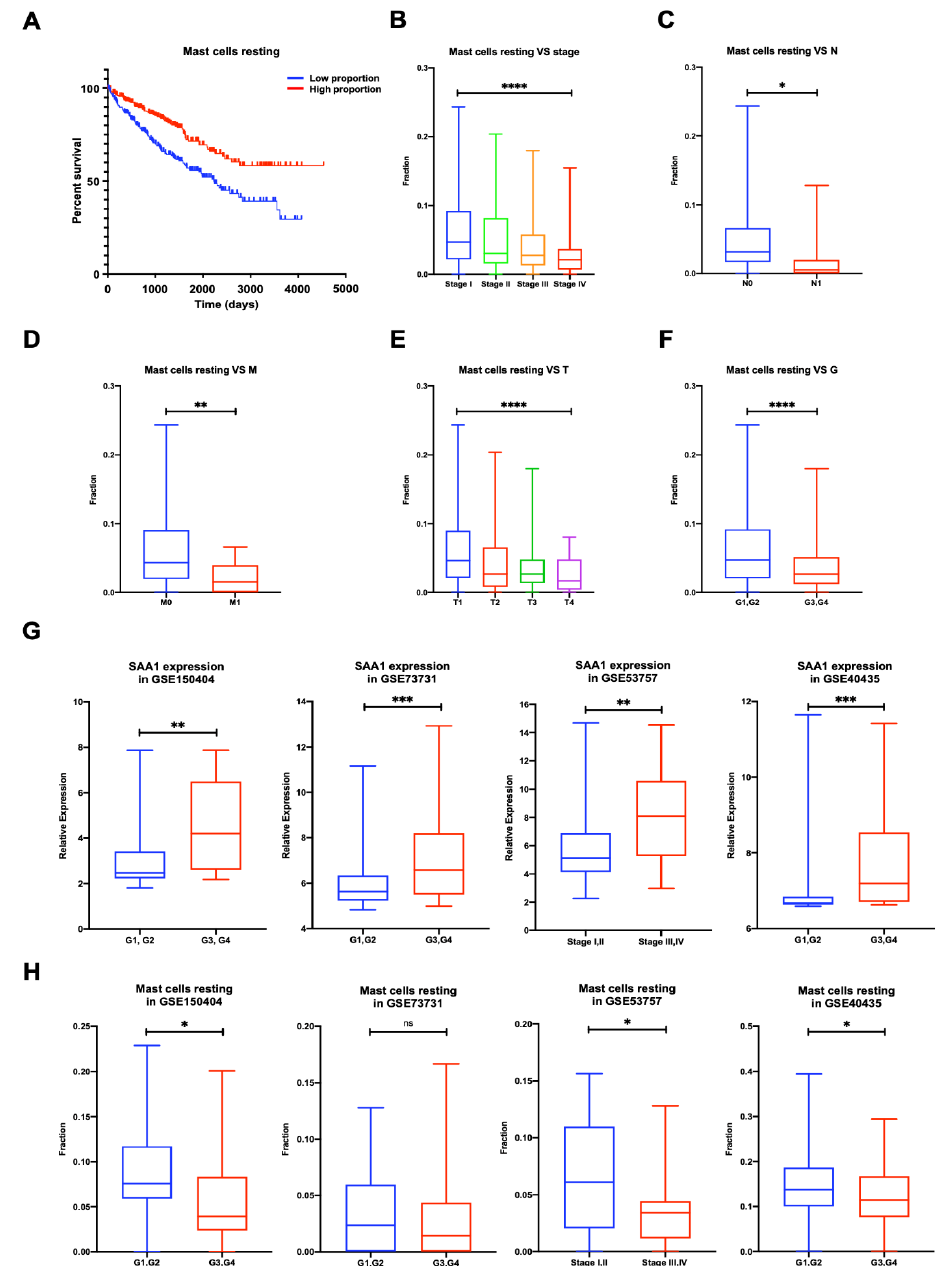
Figure 6. Proportion of mast cells resting was significantly negatively correlated to OS, stage, TNM stage, and grade of ccRCC, and validation of the correlation between SAA1 expression, mast cells resting proportion, and tumor grade or tumor stage in validation GEO cohorts. ( A ) Less mast cells resting predicted poorer OS; ( B ) less mast cells resting was associated with higher stage; ( C ) less mast cells resting was associated with higher chances of lymph node metastases; ( D ) less mast cells resting was associated with metastases. ( E ) Less mast cells resting was associated with higher T stage. ( F ) Less mast cells resting was associated with higher Fuhrman grade. ccRCC, clear cell renal cell carcinoma; OS, overall survival. ( G ) Correlation of SAA1 expression and tumor grade or stage in GEO datasets. ( H ) Correlation of mast cells resting and tumor grade or stage in GEO datasets. Note: * p < 0.05, ** p < 0.01, *** p < 0.001, **** p < 0.0001, ns p >